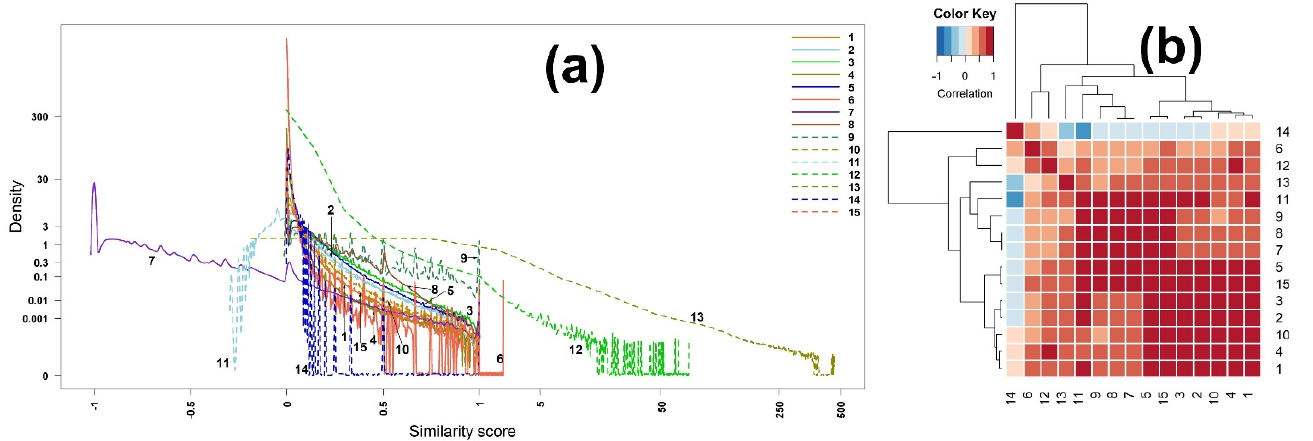
Figure 4. ( a ) Densities and ( b ) heatmap of the correlation matrix of scores among all 15 binary similarity measures for ESI mass spectra-based compound identification. The correlation was calculated using Pearson’s correlation coefficients. The horizontal red solid line indicates the four clusters generated by hierarchical clustering. The numbers in row and column represent the indices of binary similarity measures corresponding to Table 4 of Section 4.